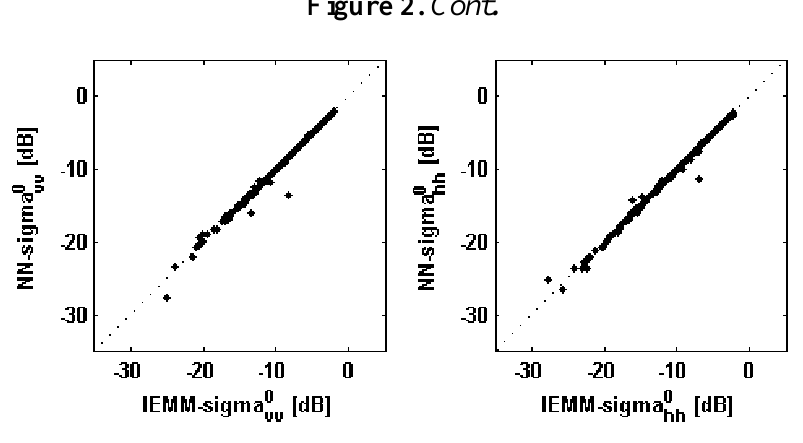
s . Left panels: vertical polarization; right 0